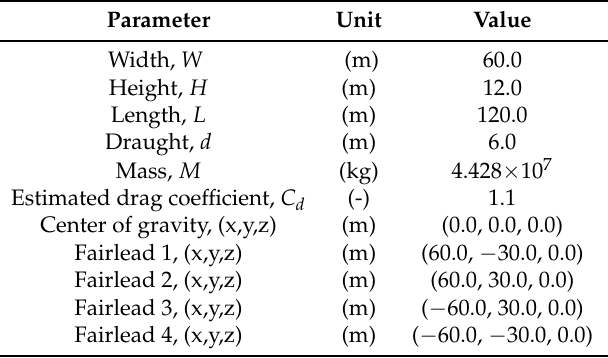
Table 5. Geometrical specification of the investigated WEC.